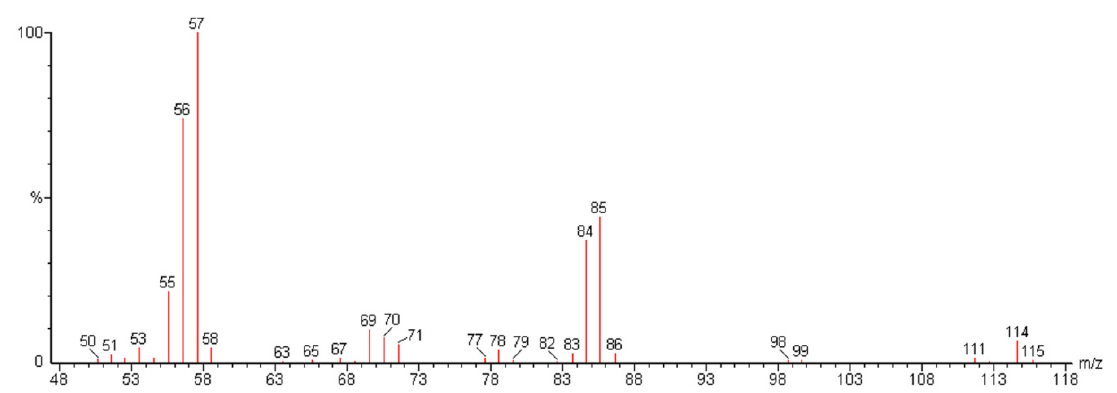
Figure 4. MS spectrum for the peak with a retention time of 4.33 min.